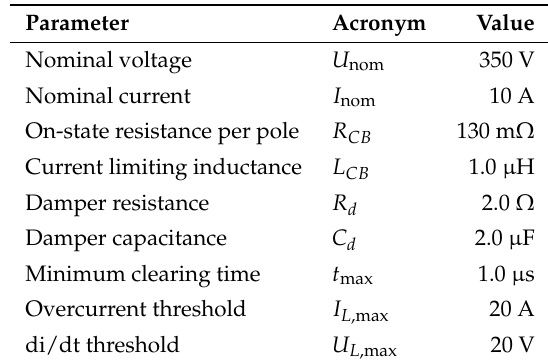
Table 2. Design parameters of the solid-state circuit breaker.